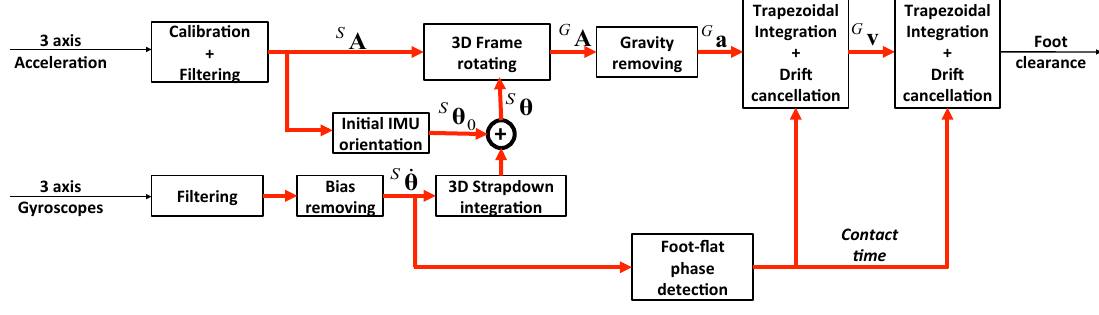
Figure 2. IMU-based foot clearance estimation